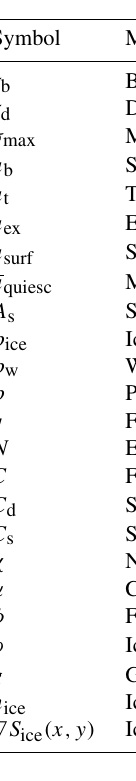
Table B1. Summary of